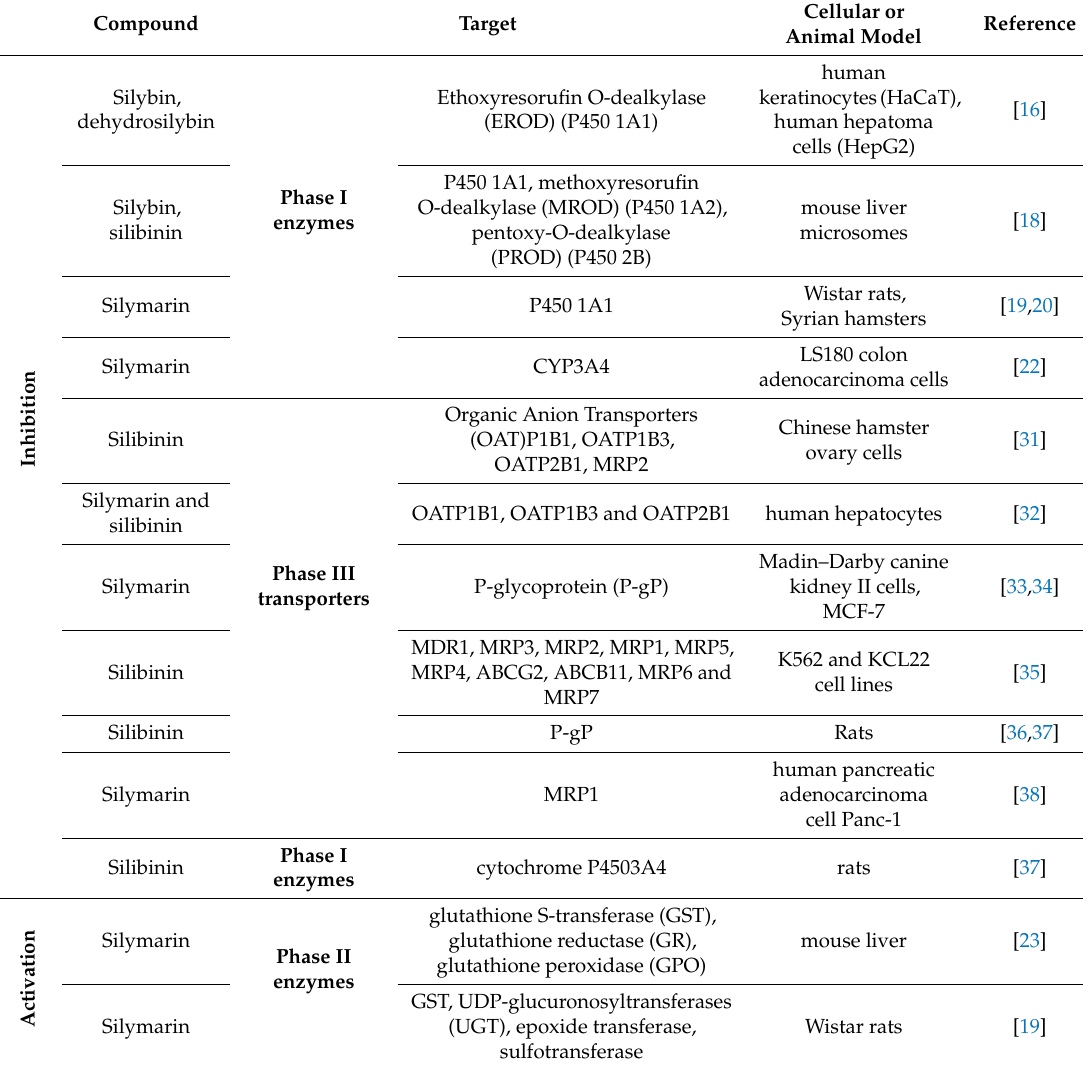
Table 1. Targets in cellular and animal models of Milk Thistle’s Active